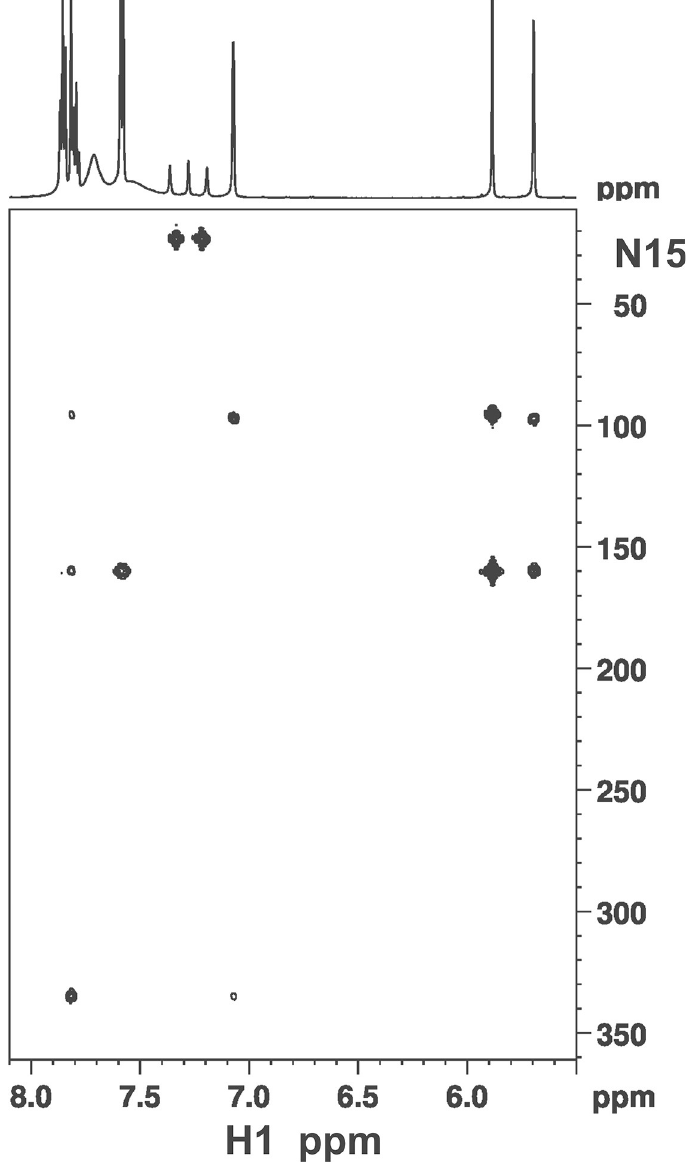
Fig 6. Natural abundance 15 N-HMBC spectrum of safranine III. At the top is the correlating 1-dimensional 1 H spectrum. The weak crosspeaks between H (4)— N (10) and H (7)– N (5) result from 4-bond J-couplings in this highly conjugated